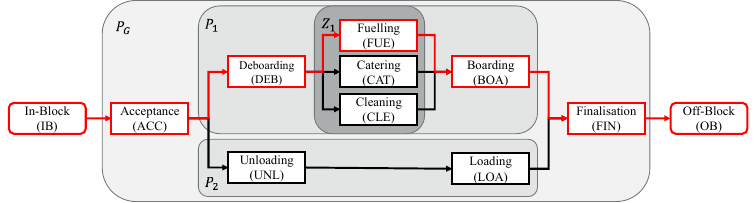
Fig. 1. Metra Potential Method (MPM) of a typical Turnaround